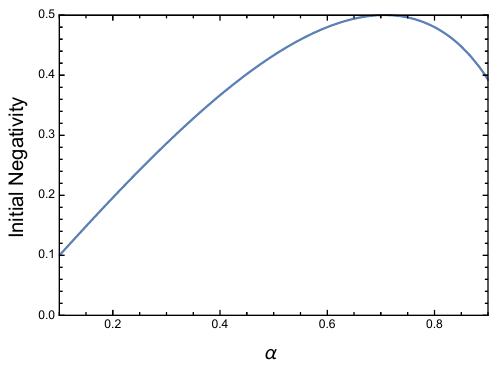
Figure 2 . N = | − αγ | VS α plot under the constraint | α | 2 + | γ | 2 = 1 .